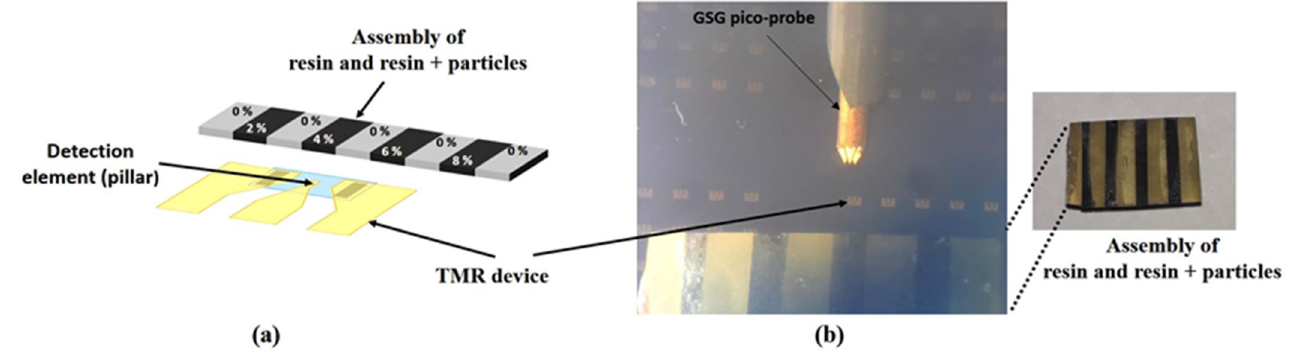
Figure 4. ( a ) Schematic representation of the resin/resin + magnetic particle assembly with different concentrations and of the magnetoresistive device; ( b ) Optical image of the sensor and the resin/resin + particle assembly, before being placed in the detection area.